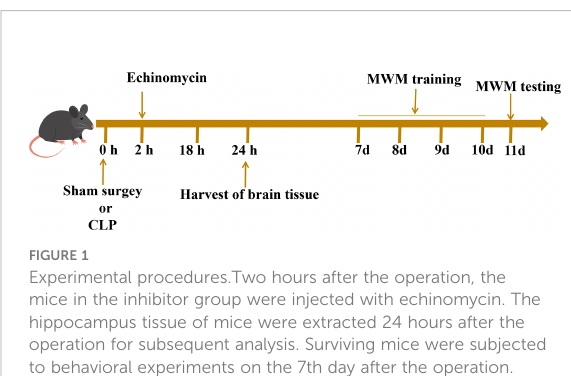
FIGURE 1 Experimental procedures.Two hours after the operation, the mice in the inhibitor group were injected with echinomycin. The hippocampus tissue of mice were extracted 24 hours after the operation for subsequent analysis. Surviving mice were subjected to behavioral experiments on the 7th day after the